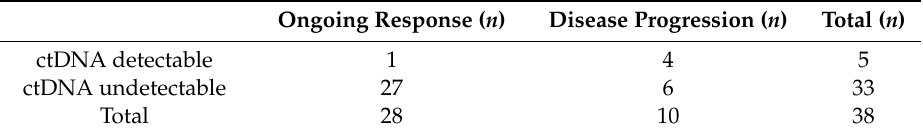
Table 3. Plasma ctDNA results at time of cessation relative to clinical